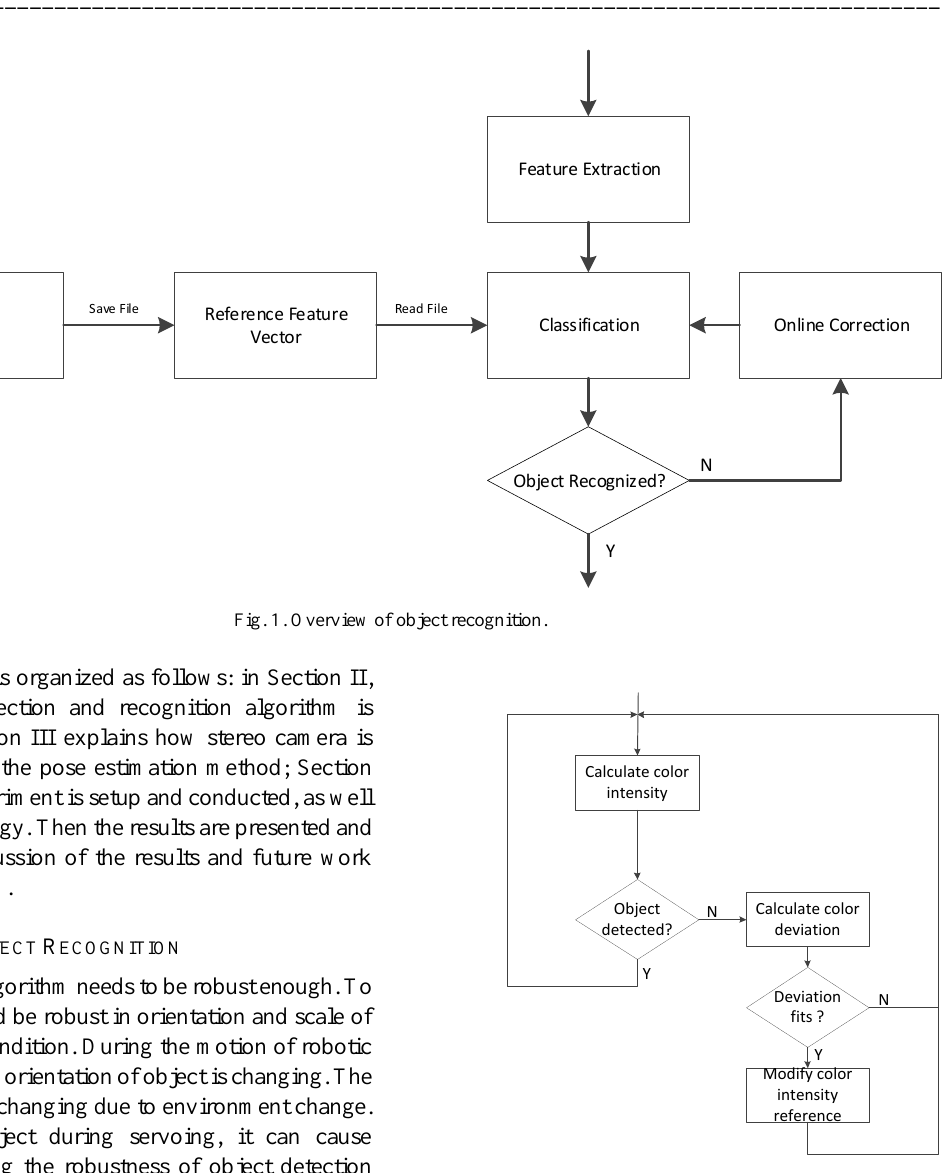
Fig. 2. Online correction